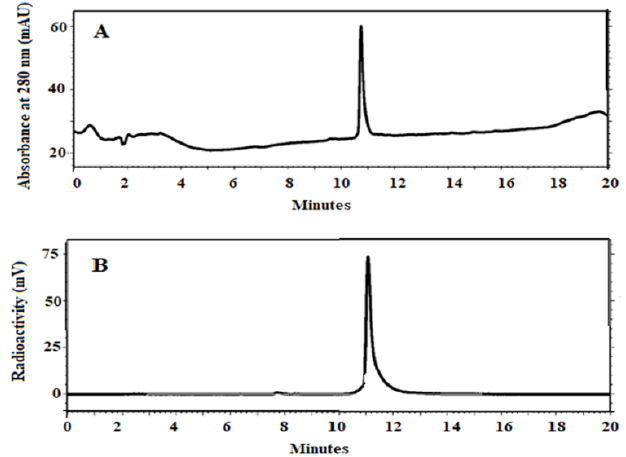
Figure 4. Characterization of anti-B7-H3 Affibody molecule. Reversed-phase HPLC chromatograms of non-labelled ( A ) AC12-GGGC and radiochromatogram of ( B ) [ 99m Tc]Tc-AC12-GGGC. The retention times (Rt) are expressed in minutes.